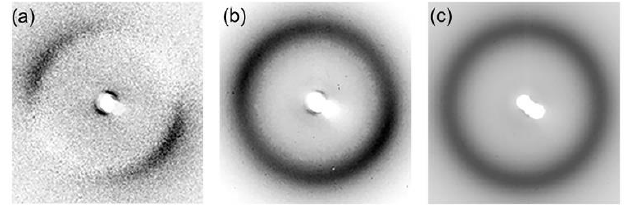
Figure 21. ( a ) μ -XRD pattern from a single spherical droplet after subtraction of the isotropic background due to scattering from the polymer; ( b ) corresponding μ -XRD pattern before background subtraction; ( c ) background diffraction pattern from the polymer binder. The pattern in ( a ) is obtained subtracting the pattern ( c ) from ( b ). Adapted from [78] with the editor’s permission.